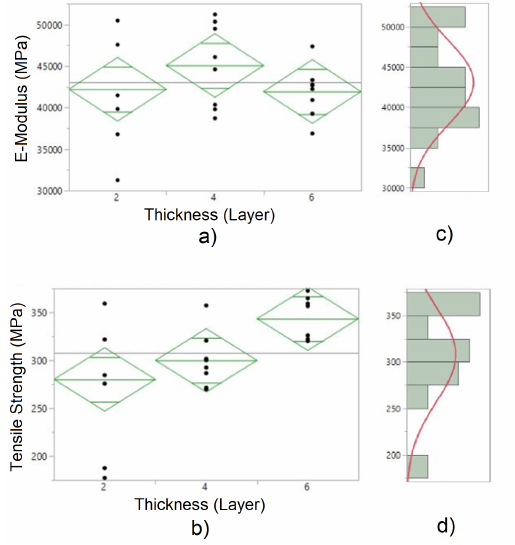
Figure 9. Oneway ANOVA: a) E -Modulus over thick- ness, b) Tensile strength over thickness, c) E -Modulus distribution, d) Tensile strength